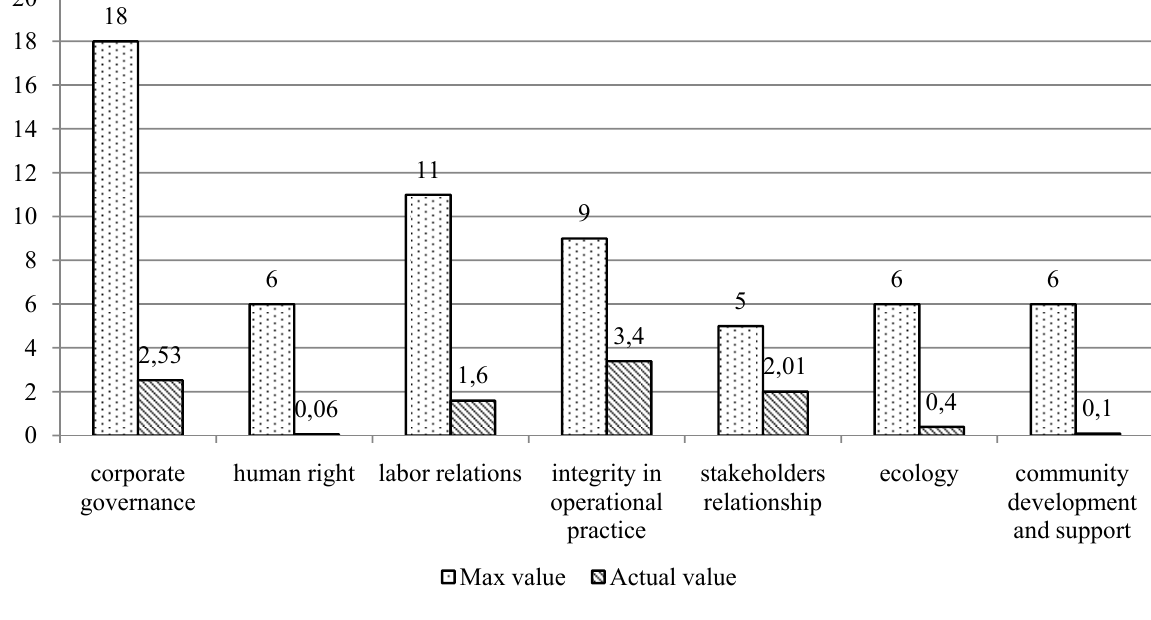
Fig. 2. The level of disclosure on the websites of companies on the parameter of “Content”, points, Center “CSR Development”